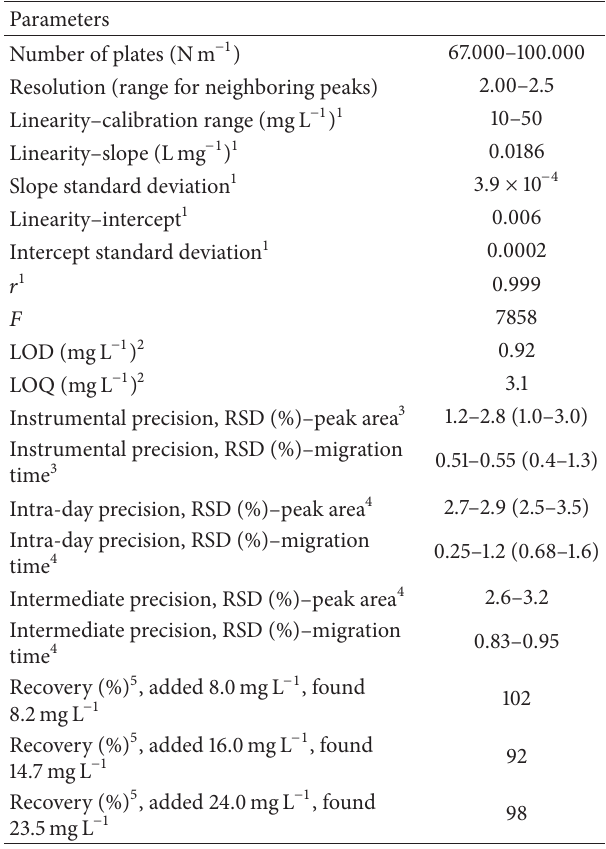
Table 1: Performance parameters of the method by CZE for analysis of lidocaine.